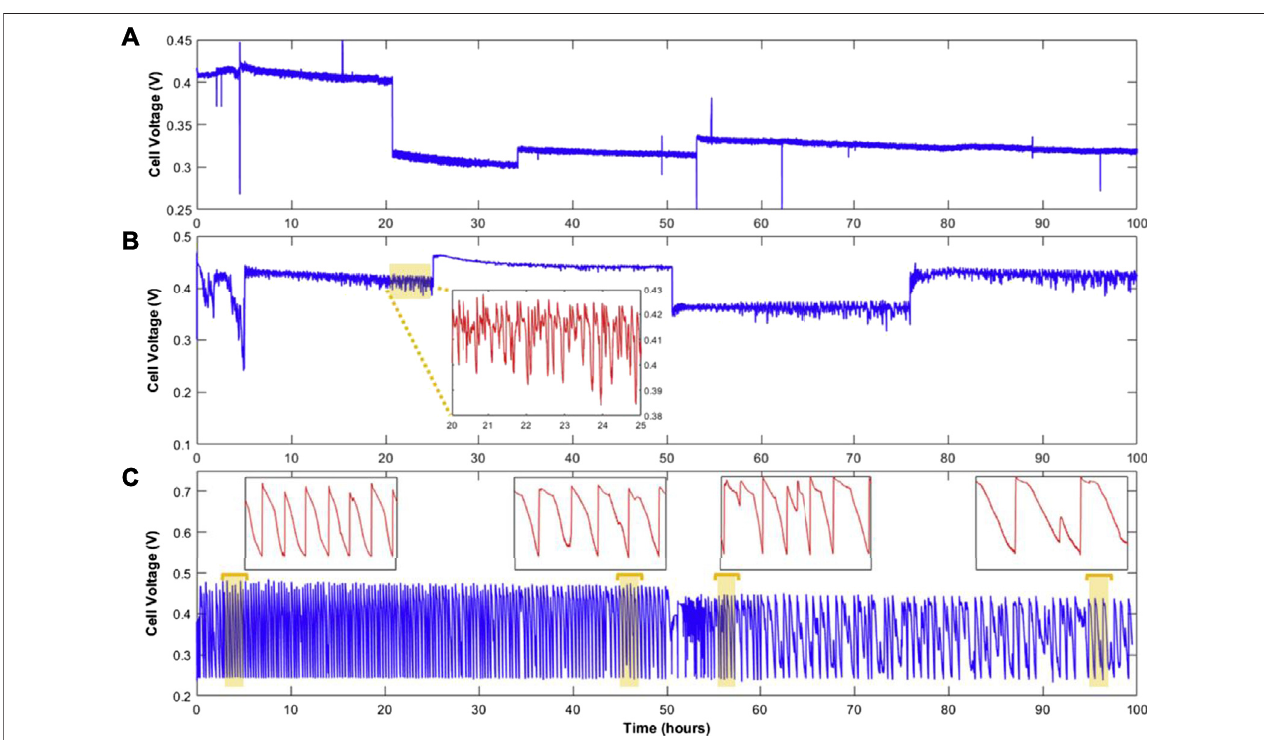
FIGURE 8 | Voltage transient at 0.67 A/cm 2 with 3 modes of operation: fl ow through (A) , anode bleeding, (B) dead-end anode (C) . In (B) , the inset demonstrates the 5-h portion of the speci fi ed area. In (C) , the 2-h insets show the frequency of the dead-end anode cycles. Reproduced with permission (Eskin and Yesilyurt, 2019). Copyright 2021,